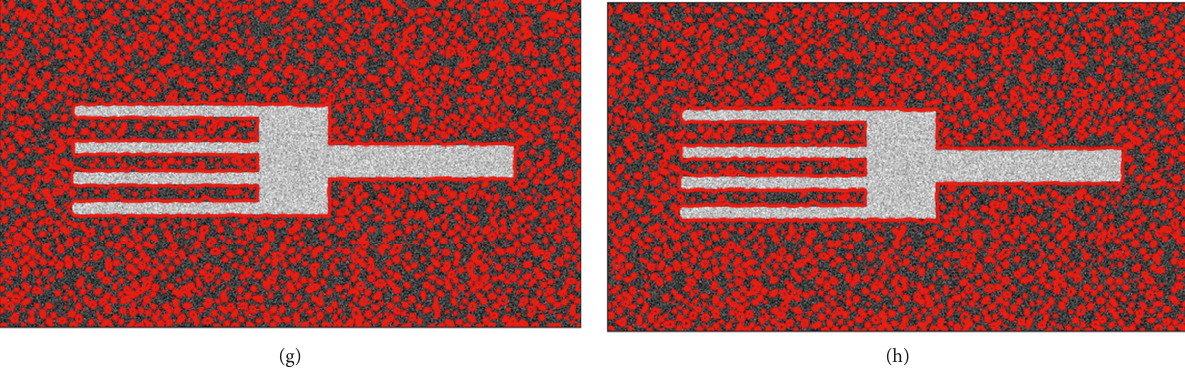
Figure 10: Verification experiment of the influence of parameter ε on segmentation performance. The relevant task parameters are μ � 0 . 03,